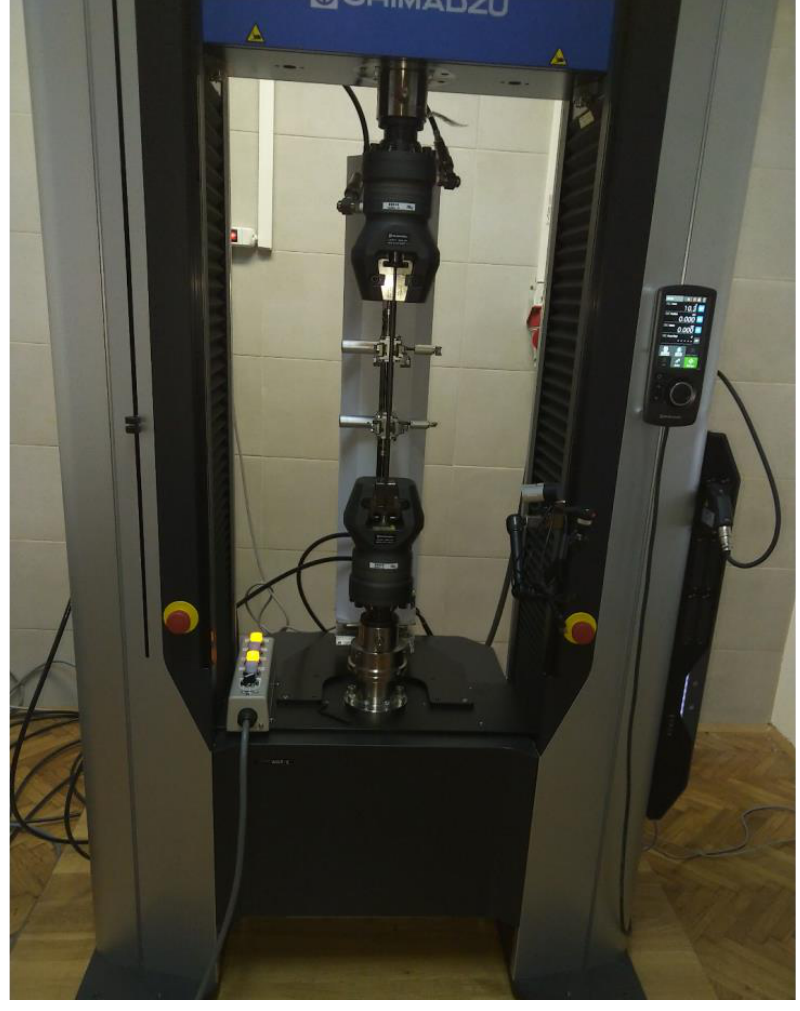
Figure 8. Tensile testing of wire sample. Table 3. Tensile test